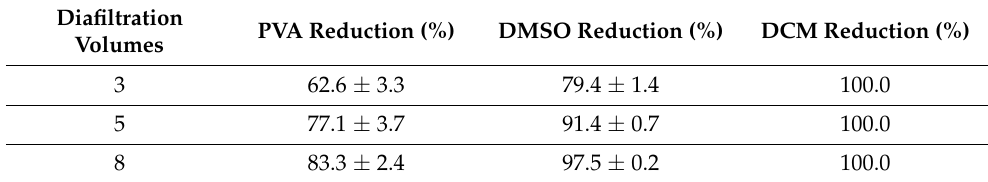
Table 5. Impact of different TFF diafiltration volumes in reducing PVA, DMSO, and DCM content.